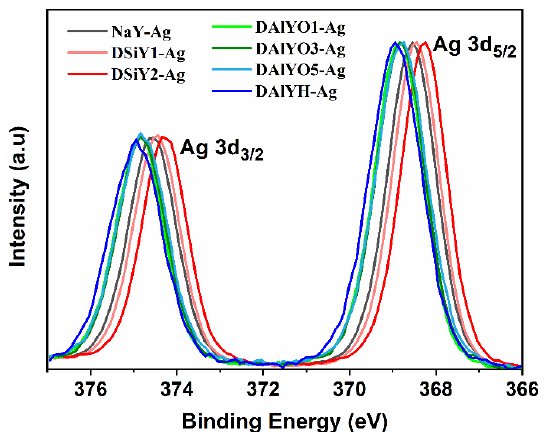
Figure 6. Normalized XPS spectra of Ag 3d in NaY-Ag, DSiY1-Ag, DSiY2-Ag, DAlYO1-Ag, DAlYO3-Ag, DAlYO5-Ag, and DAlYH-Ag.